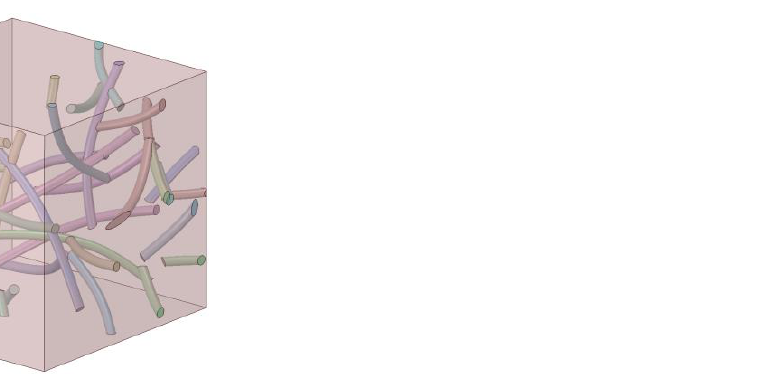
Figure 4. A model of randomly distributed CNTs at a loading of 2% vol.